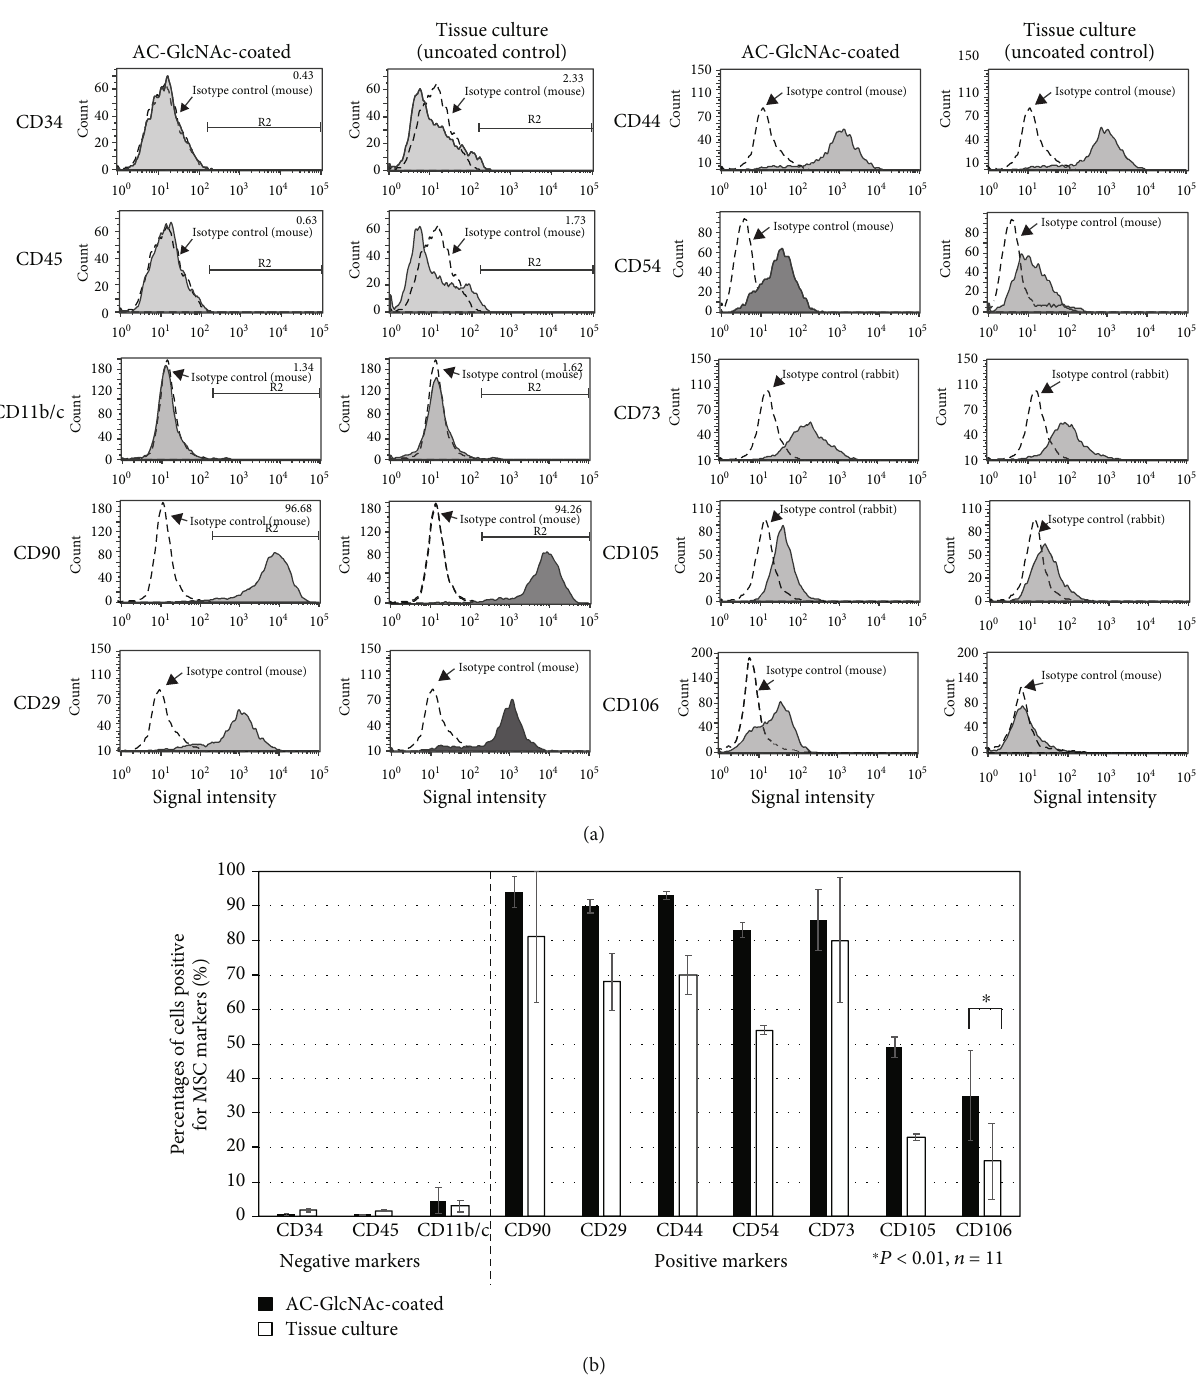
Figure 5: Flow cytometric analysis of proliferating cells from AC-GlcNAc-coated and control uncoated dishes. (a) Representative charts of fl ow cytometric analysis for expression of MSC markers (CD34, CD45, CD11b/c, CD90, CD29, CD44, CD54, CD73, CD105, and CD106) in the proliferating cells on each dish. (b) Percentages of cells positive for MSC-positive and MSC-negative